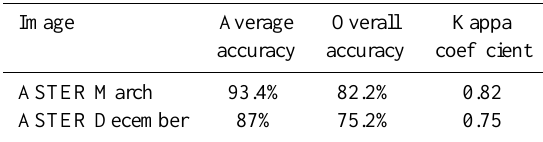
Table 3. Classification report of ASTER images.